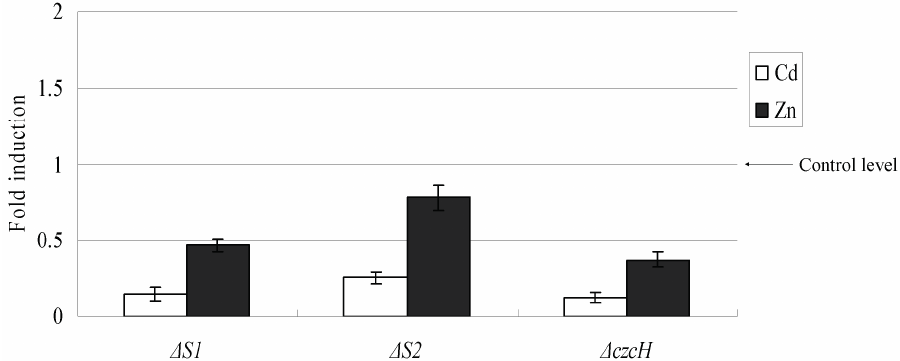
Figure 3. The effects of the mutation in czcS1 , czcS2 , and czcH on the transcription of czcA . Transcription of czcA was analyzed by qRT-PCR in the wild-type X4 strain and mutant strains grown in the presence of 300 μ M Zn 2+ or Cd 2+ . The amount of mRNA is represented relative to the wild-type X4 strain cultivated in the same concentration of metal ions. Error bars represent the standard deviations of three